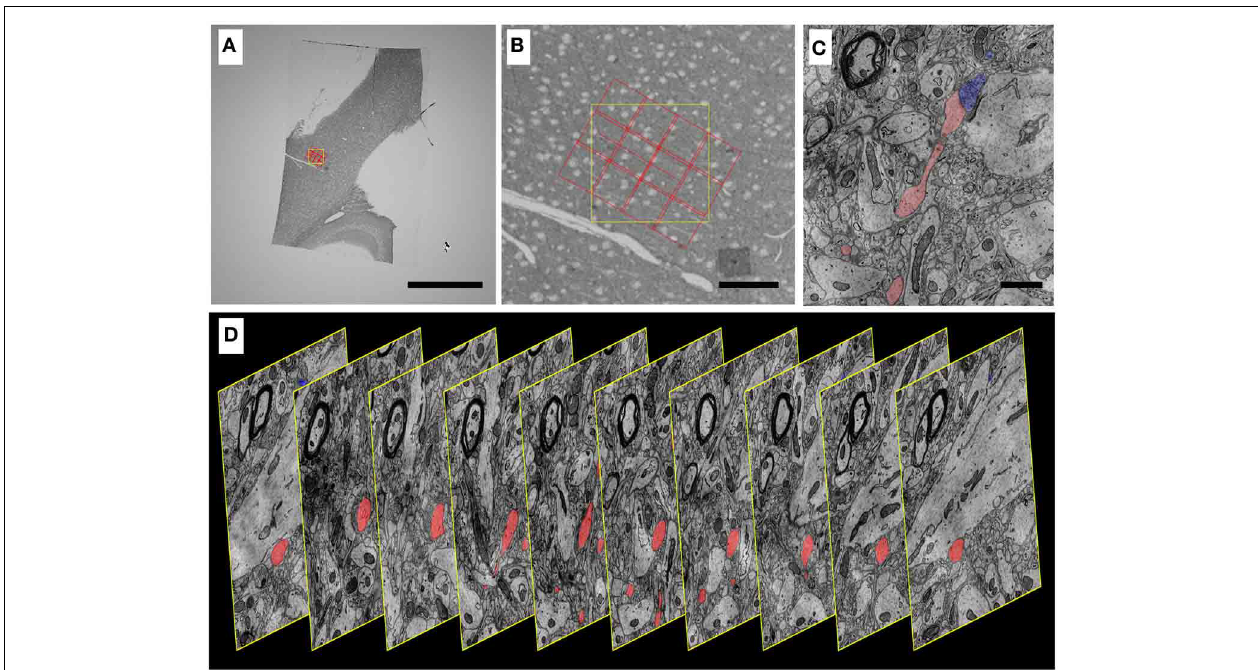
FIGURE 10 | Progressively higher resolution images through a mouse cortex UTSL mapped and imaged by the WaferMapper software. (A) Single section of the 1025 section mouse cortex UTSL whose wafers are displayed in full in Figure 6 . This image is from a screen capture of the WaferMapper program showing the location of a 3 × 4-tile montage overlaying a target region. (scale bar = 1mm). (B) Zooming in on the section overview display in WaferMapper allows the graphical display of the montage to be finely positioned relative to blood vessel and cell body landmarks visible